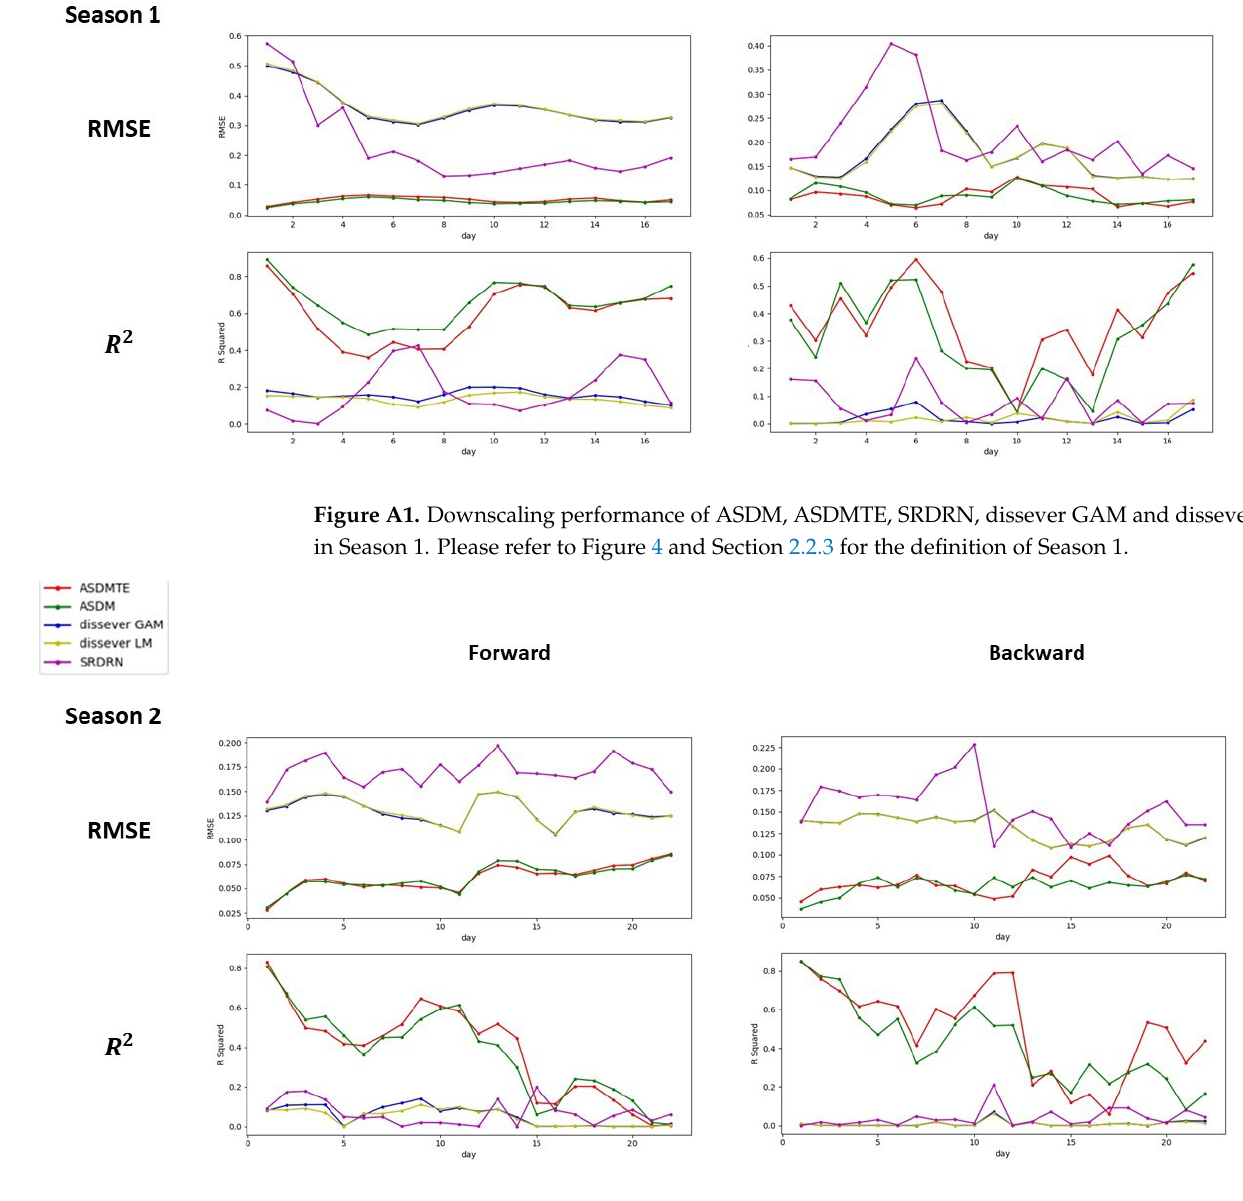
Figure A2. Downscaling performance of ASDM, ASDMTE, SRDRN, dissever GAM and dissever LM in Season 2. Please refer to Figure 4 and Section 2.2.3 for the definition of Season